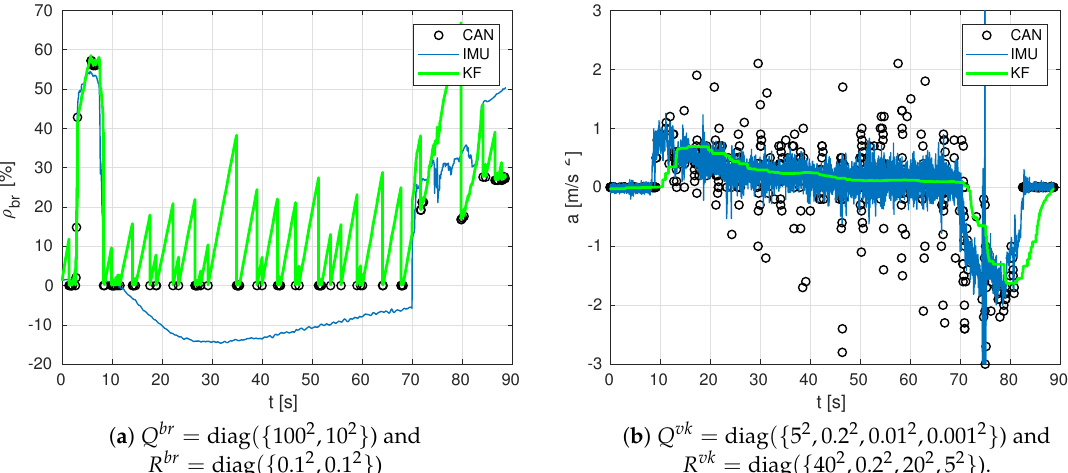
Figure 8. Estimation at a high rate of the position of brake pedal (in %) and vehicle’s acceleration, for the test at 60 km/h and high braking, with two examples of incorrect covariance matrices